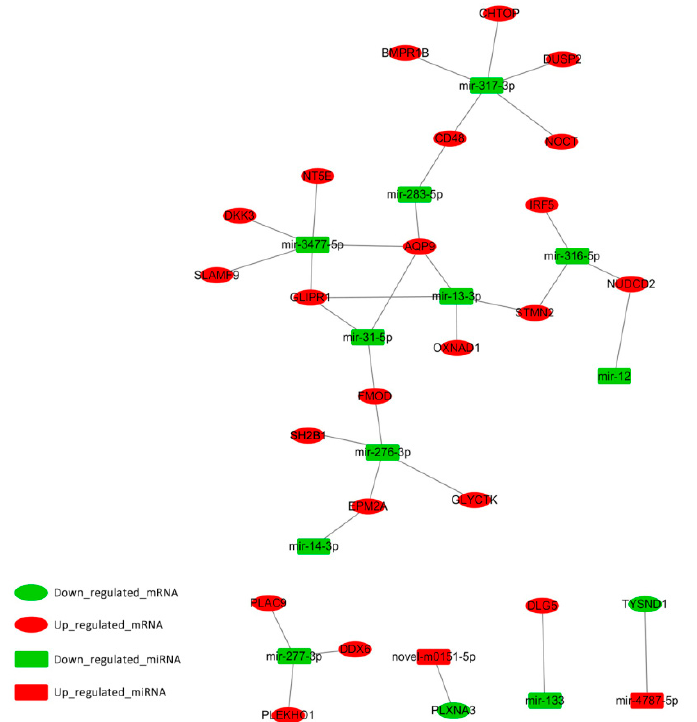
Figure 5. Regulatory network of significantly di ff erentially expressed miRNA-mRNA pairs between HBFT and LBFT pigs. Up_regulated_mRNA (down-regulated mRNA) means that the gene is highly (low) expressed in the HBFT group and low (highly) expressed in the LBFT group. Up_regulated_miRNA (down-regulated miRNA) means that the miRNA is highly (low) expressed in the high backfat HBFT group and low (highly) expressed in the LBFT group.